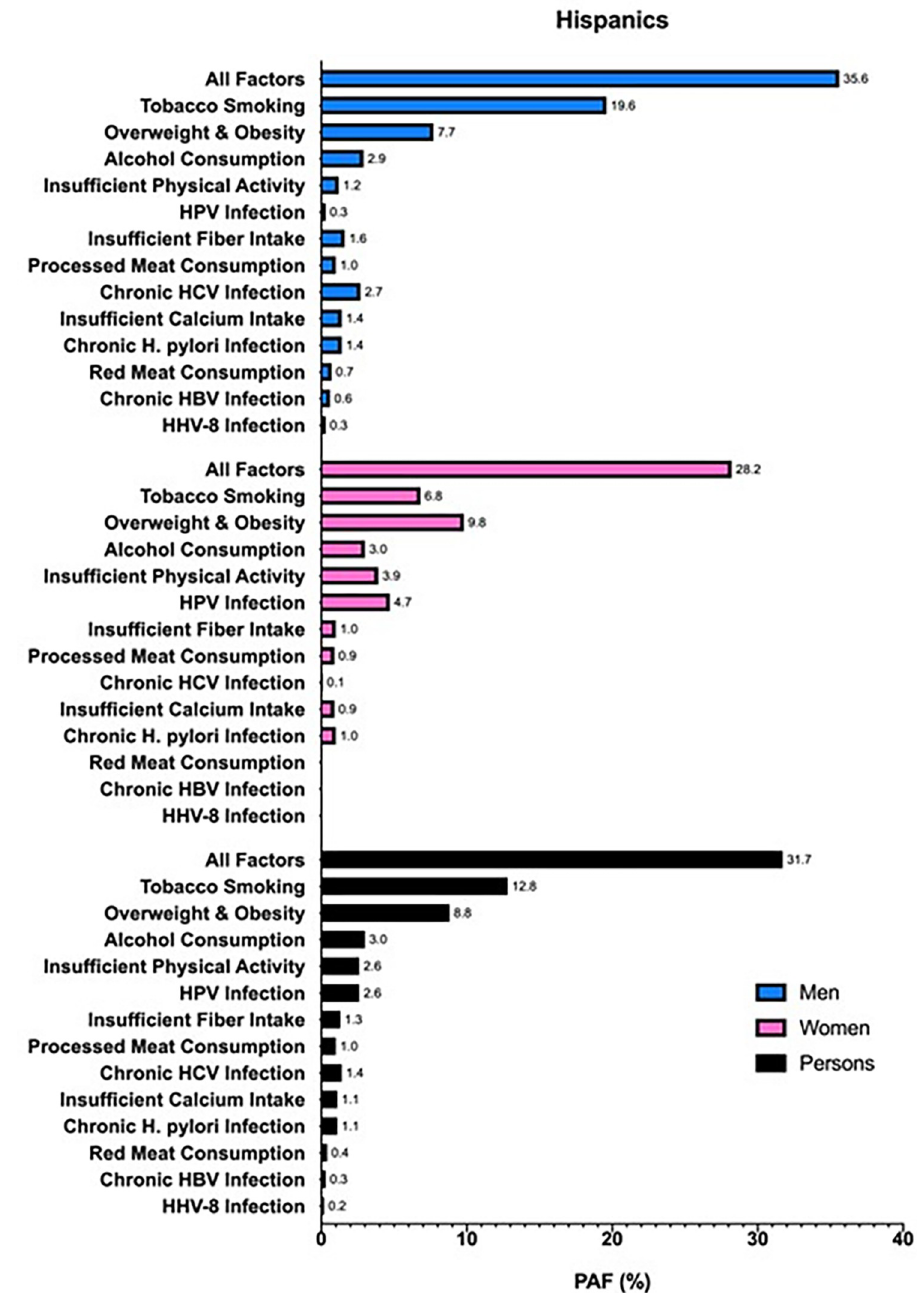
Fig 4. PAFs (%) of incident cancers attributable to modifiable risk factors in Texas in 2015 for Hispanic men (blue), women (pink), and persons (black) aged � 25 years. lung and bronchus (84.7%); mouth, pharynx, and larynx (72.3%); and esophagus (66.8%) for all races/ethnicities combined (Fig 5). This trend was consistent in non-Hispanic Whites (lung, bronchus, 84.7%; mouth, pharynx, larynx, 71.0%; esophagus, 66.3%) and in Hispanics (lung, bronchus, 80.1%; mouth, pharynx, larynx, 69.8%; esophagus, 66.4%), while in non-